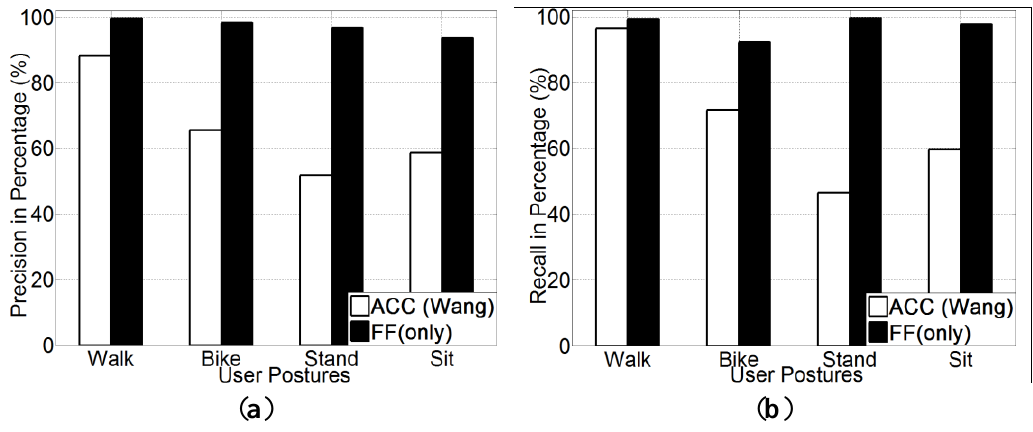
Figure 7. Human posture and mobility recognition results using naive Bayes: ( a ) precision; ( b )